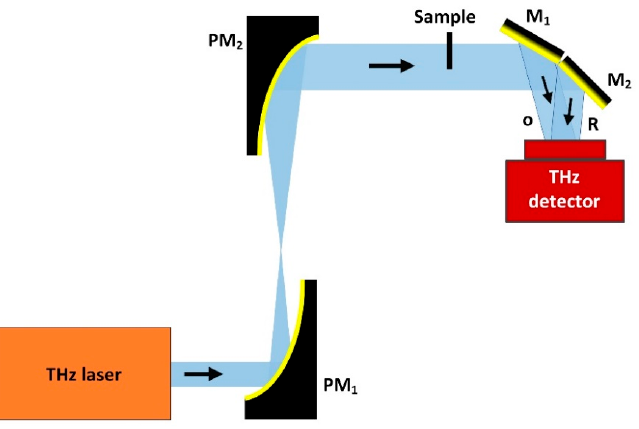
Figure 10. Schematic layout of the setup of self-referencing CW TDH based on Fresnel’s mirrors. O: object beam; R: reference beam.